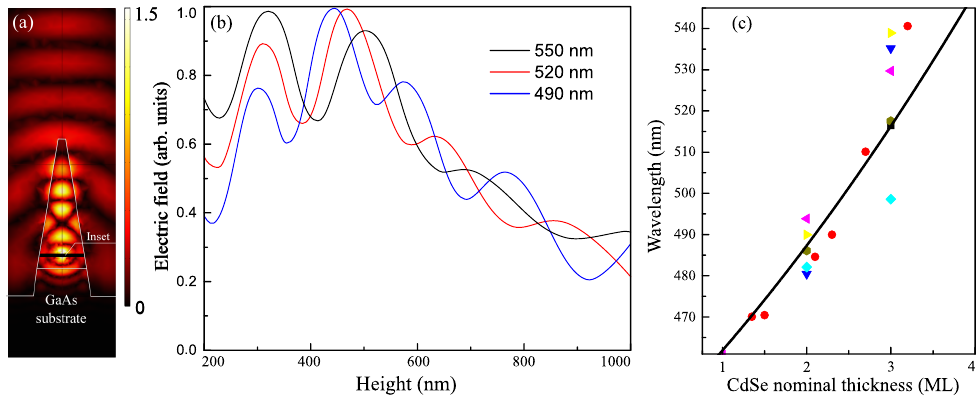
Figure 2. Typical electromagnetic field distribution inside and outside of the nanocolumn at the wavelength of 520 nm. ( a ) Color bar shows the normalized values of modulus of the electric field. ( b ) The modulus of the electric field dependence on the CdSe QD height inside a 1.6 µ m-long nanocolumn, calculated for wavelengths marked in a plot and normalized to the maximum of the amplitude for each wavelength. ( c ) Dependence of the radiation wavelength of CdSe/ZnSe QDs on the nominal thickness of a CdSe layer, deposited at the molecular beam epitaxy (MBE) growth, given in monolayers. Different symbols mark various growth runs. The PL measurements were performed at 77